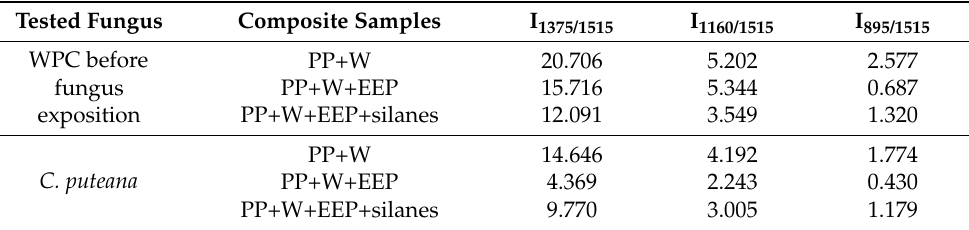
Table 1. Relative changes in the ratios of carbohydrate bands with lignin reference band in composite samples decayed by wood rot